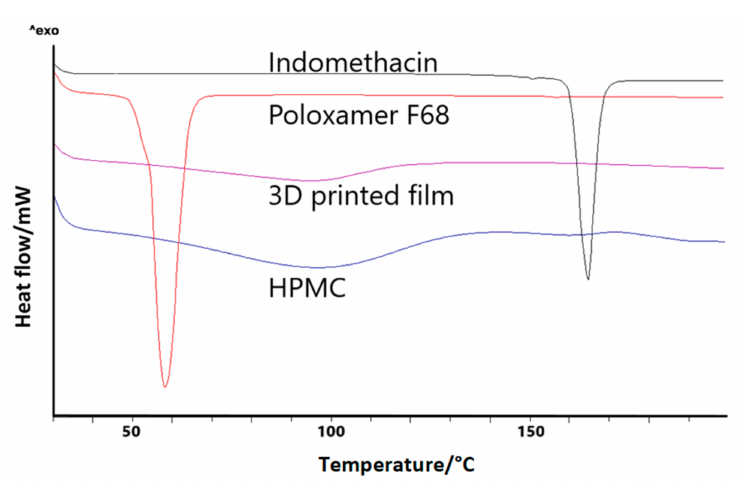
Figure 1. DSC thermograms of indomethacin, Poloxamer F68, HPMC, and 3D-printed film (exo up). From the drug-loaded films, particle size after redispersion of the film pieces, visual appearance of the films, thickness, number of foldings before film breaking, weight varia- tion of film pieces, drug content in the film pieces, and disintegration time were analyzed (Table